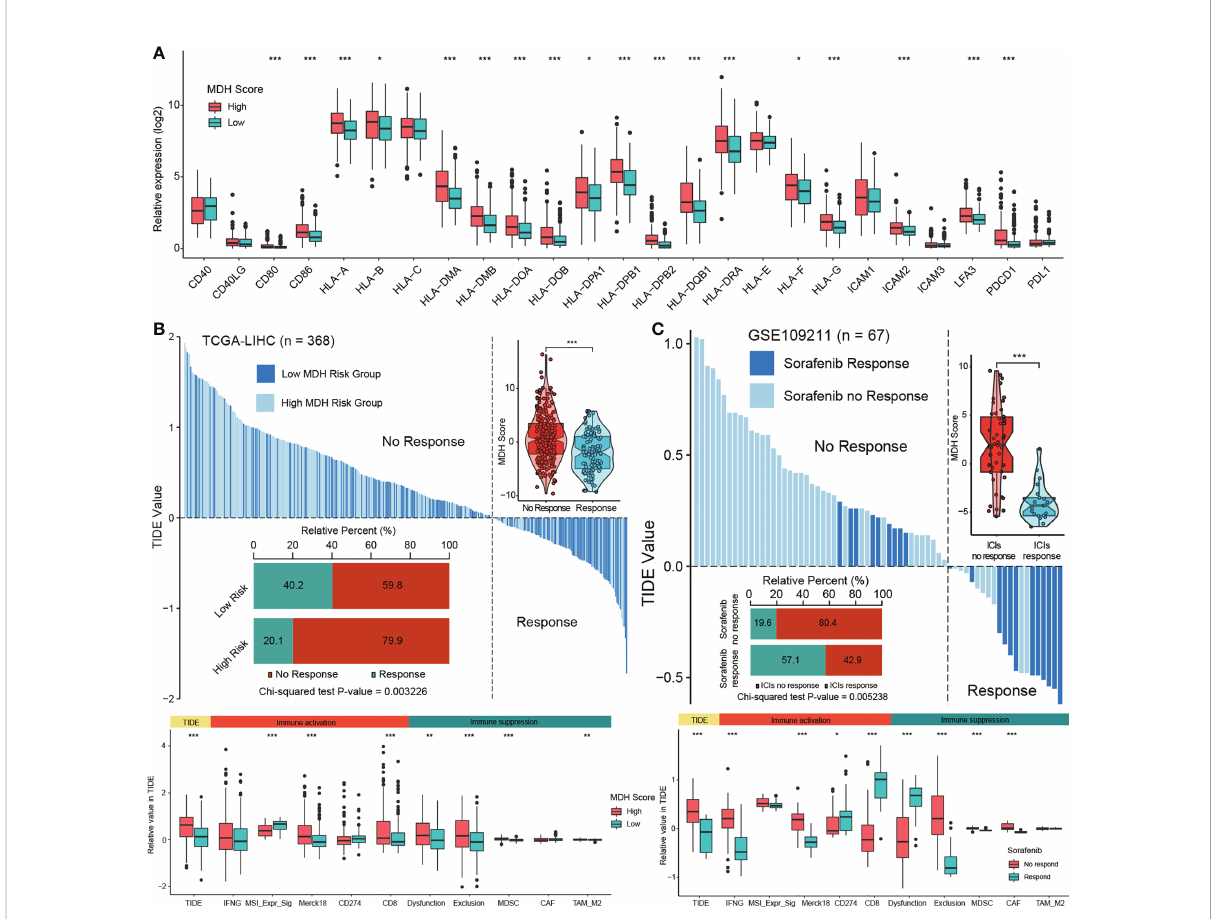
FIGURE 6 The MDH score predicts the immunotherapy response in HCC. (A) Differences in the expression of MHC molecules, costimulatory molecules and adhesion molecules in the MDH high- or low-score groups of the TCGA-LIHC cohort. The upper and lower ends of the boxes represent the interquartile range of values. The lines in the boxes represent the median value, and black dots show outliers. (B) TIDE value of MDH high- or low-score groups of TCGA-LIHC cohort. (C) TIDE values of sorafenib responders and nonresponders in the GSE109211 cohort. The chi-square test was used to calculate signi fi cant differences in (B, C) The asterisks represent the statistical p-value (*P< 0.05; **P< 0.01 and ***P<